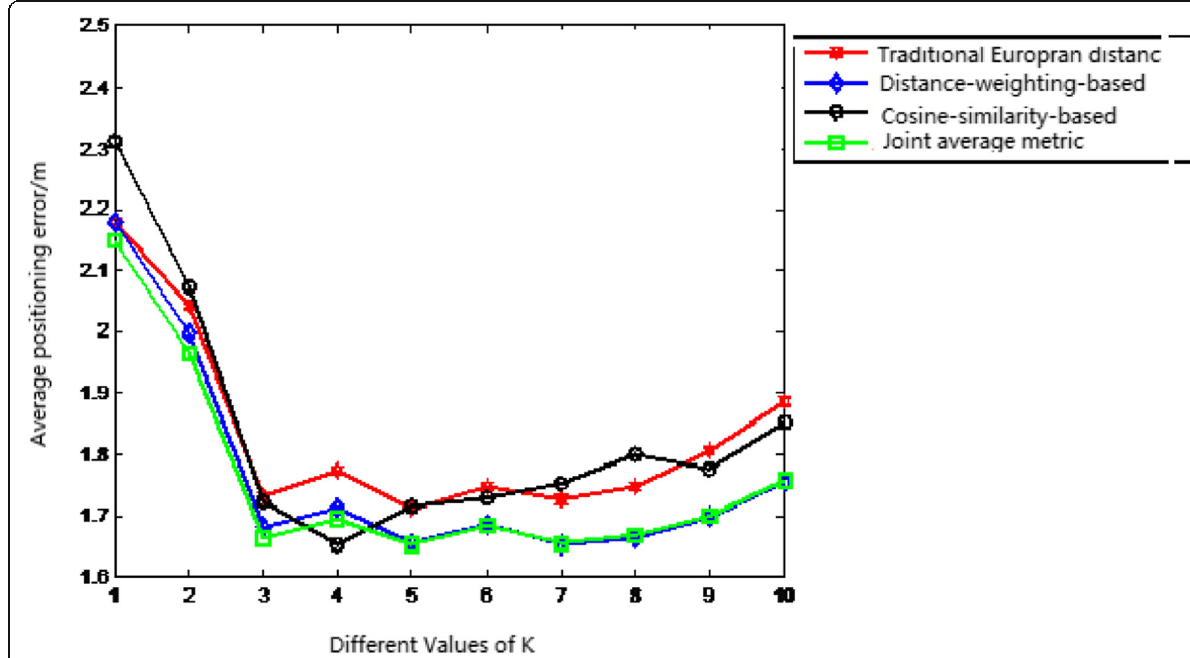
Fig. 10 Deviation map of four positioning algorithms under different k